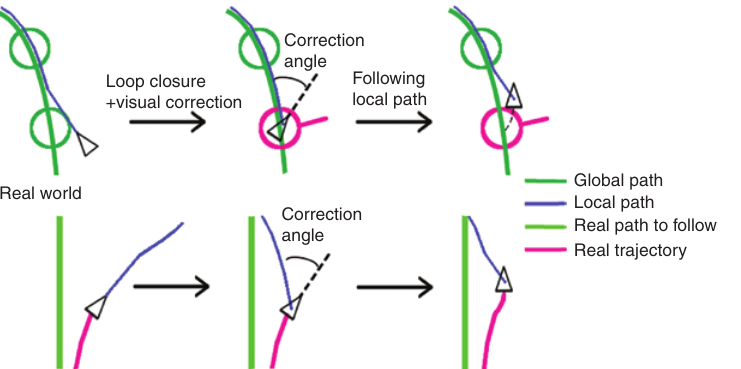
Figure 8. Path-Following